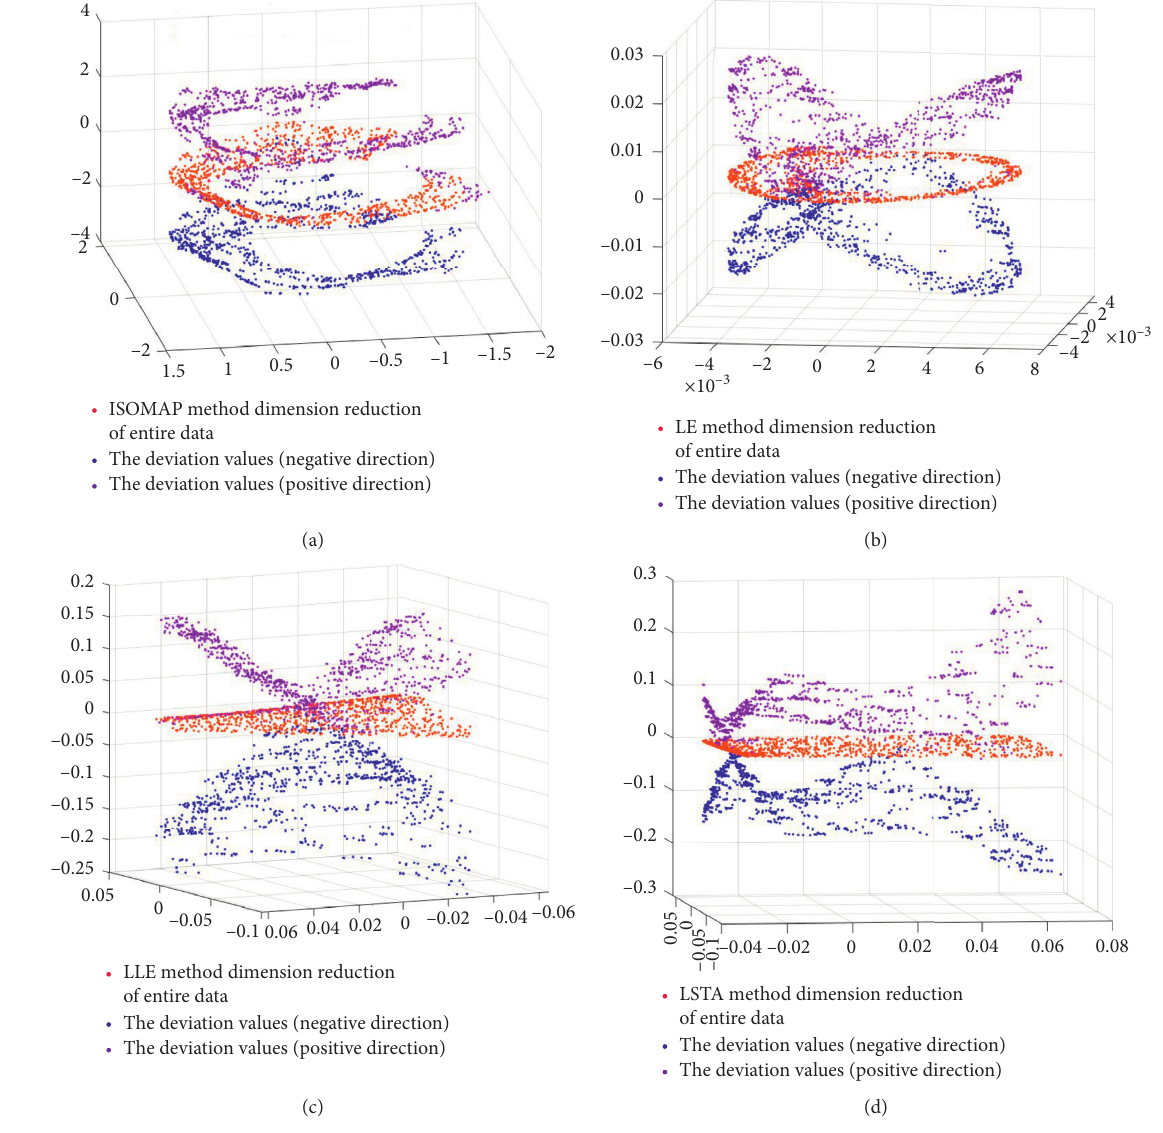
Figure 8: Dimension reduction and deviation value results for entire noisy Swiss roll data.